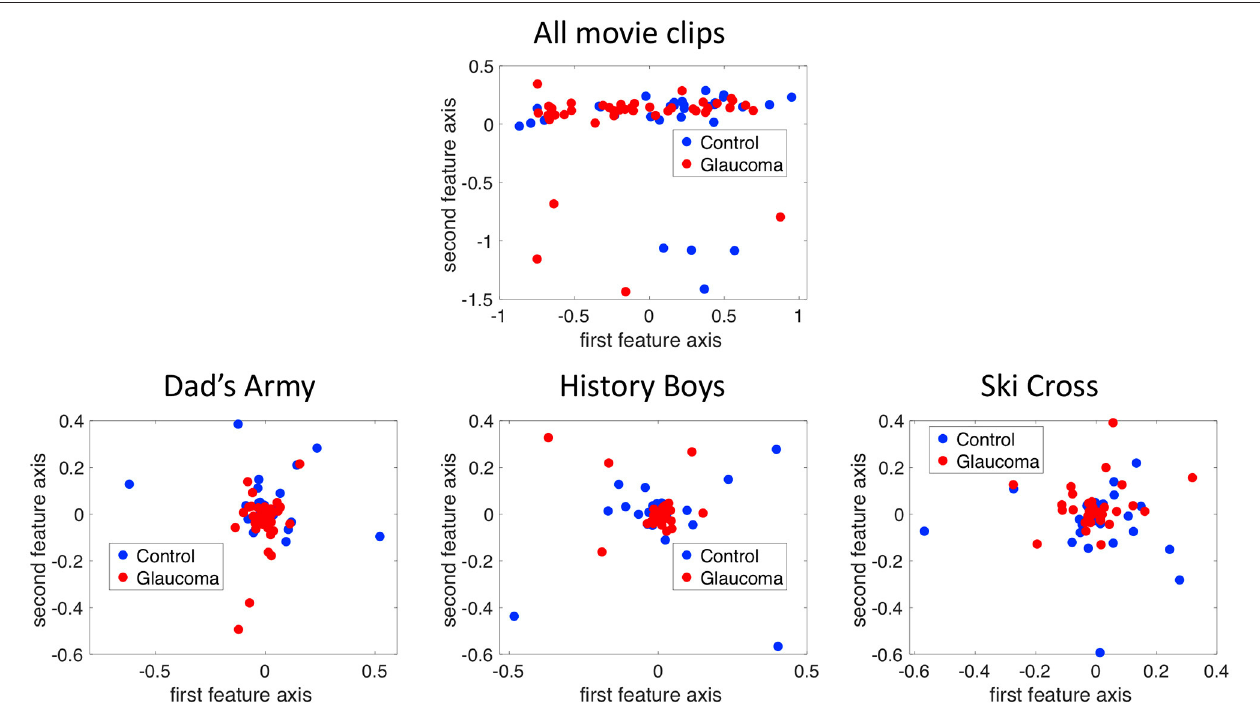
FIGURE 14 | Projection of the 8 by 10 bin fixation maps onto the first two principal axes in the kernel space using the combined data of all three trials and the data of each trial separately.